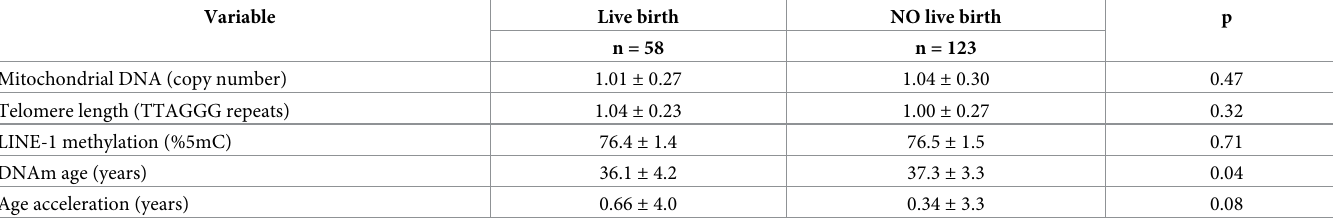
difference emerged only for DNAm age. Specifically, the mean ± SD biological age was live birth. The ROC curve aimed at assessing the accuracy of DNAm age in predicting live birth rate showed an AUC of 0.57 (95%CI: 0.48–0.66). Women with a biological age � 10 th centile (corresponding to 32 years) had an Odds Ratio (OR) of 2.4 (95%CI: 1.0–5.9, p = 0.05) for live birth. Multivariate analyses adjusting for the variables found to differ between women who did and did not achieve a live birth are shown in Table 4. As aforementioned before, two different Table 3. Biomarkers of aging in women who did and did not achieve a live